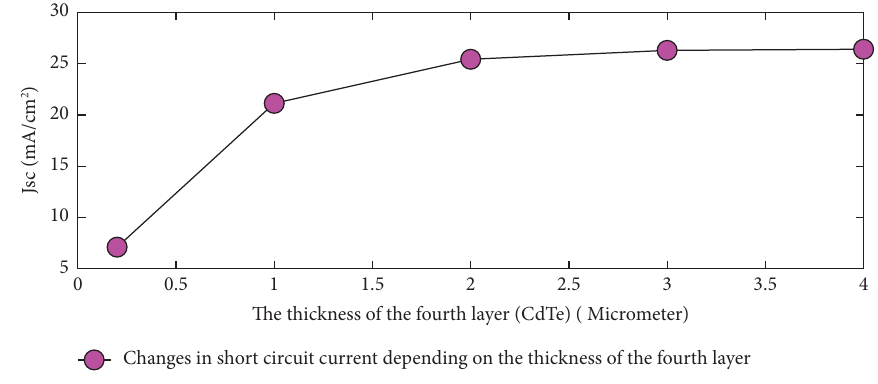
Figure 10: Short-circuit current diagram according to CdTe layer thickness.